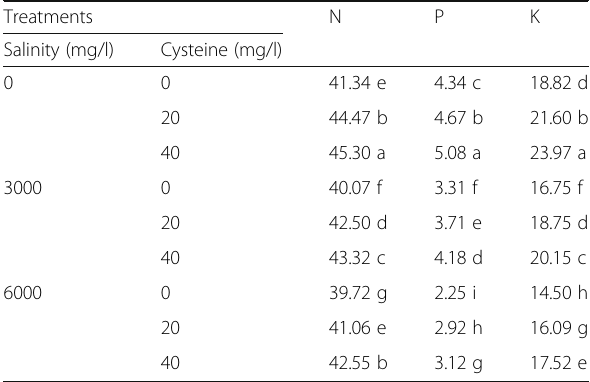
Mean values ( n =3) in each column followed by a different letter are significantly different at ≤ 0.05 by Duncan ’ s multiple range test